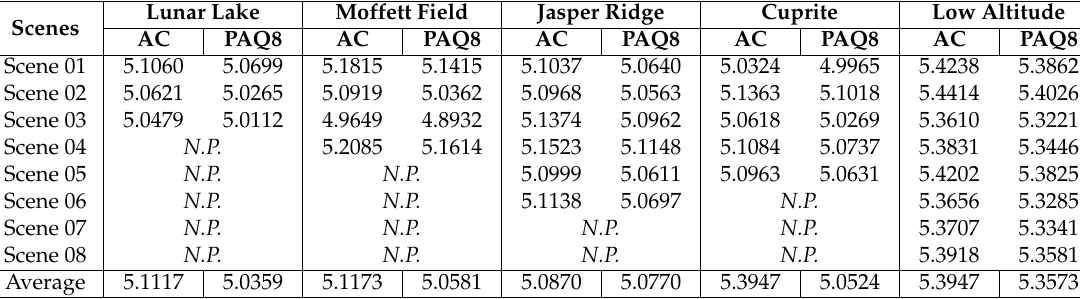
Table 6. Achieved results by using the following parameters: N “ 8, B “